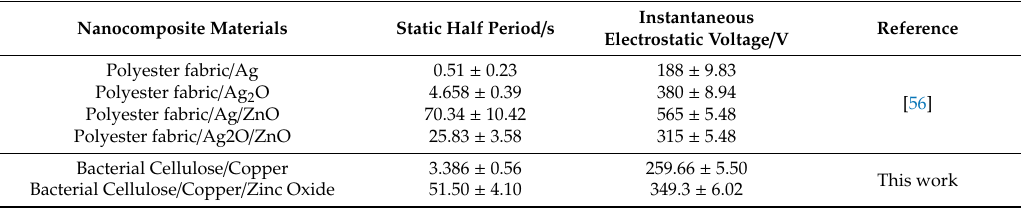
Table 2. Comparison of di ff erent nanocomposite materials in terms of antistatic characteristics.